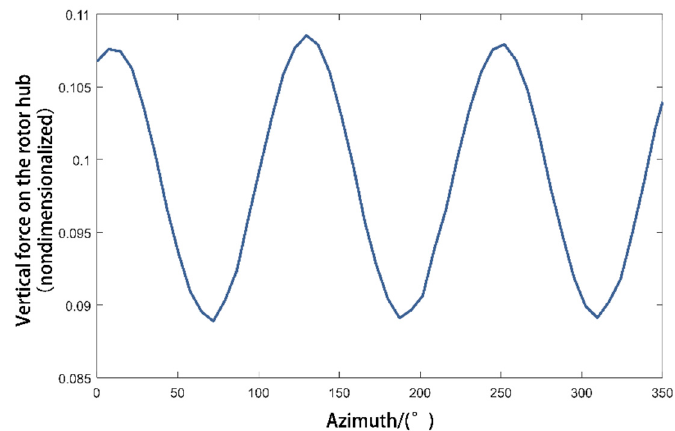
Figure 16. Vertical force on the rotor hub (nondimensionalized).